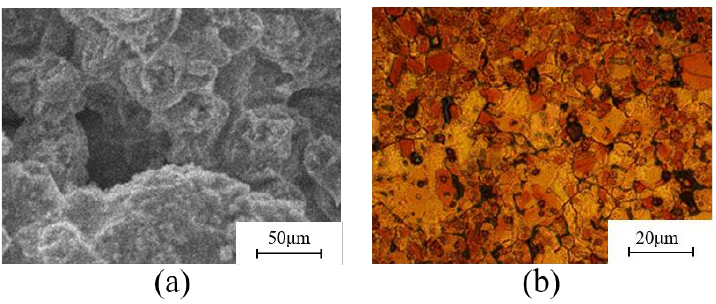
Figure 6. ( a ) SEM photos of matrix metal. ( b ) Microstructure photos of matrix